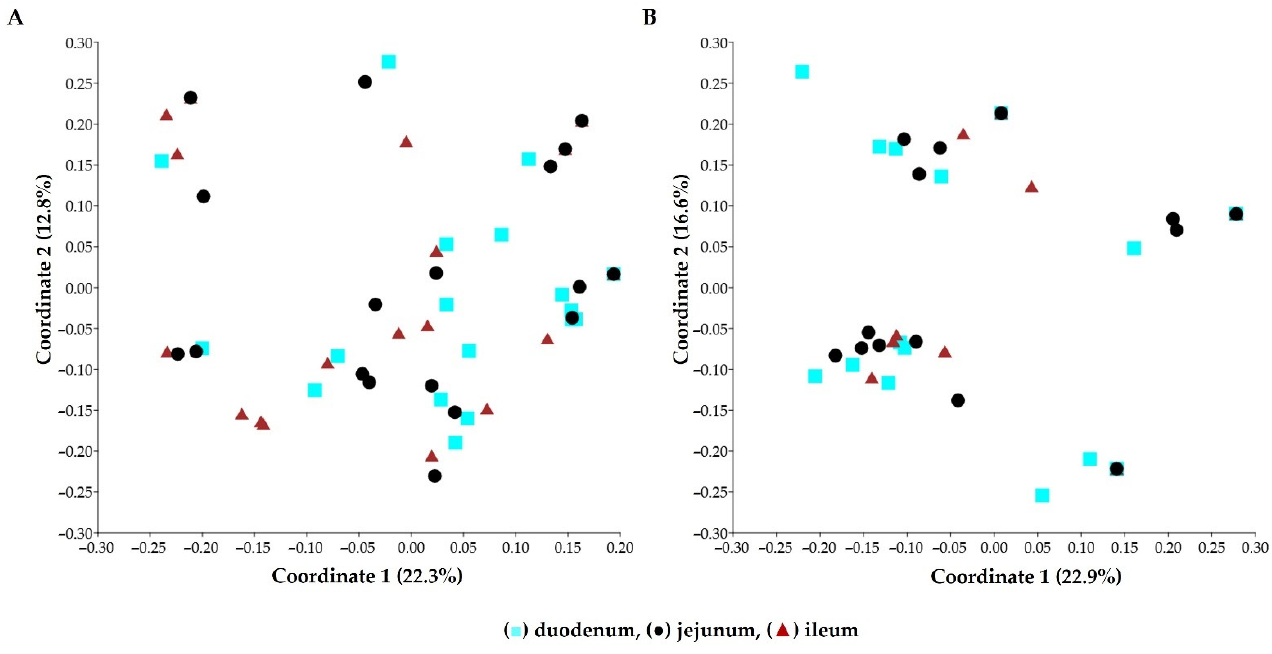
Figure 2. Principal coordinate analysis (PCoA) plots of yeast communities in ( A ) 54 pia samples and ( B ) 50 small-intestinal epithelial samples of the duodenum, jejunum, and ileum using the Jaccard similarity coefficient.